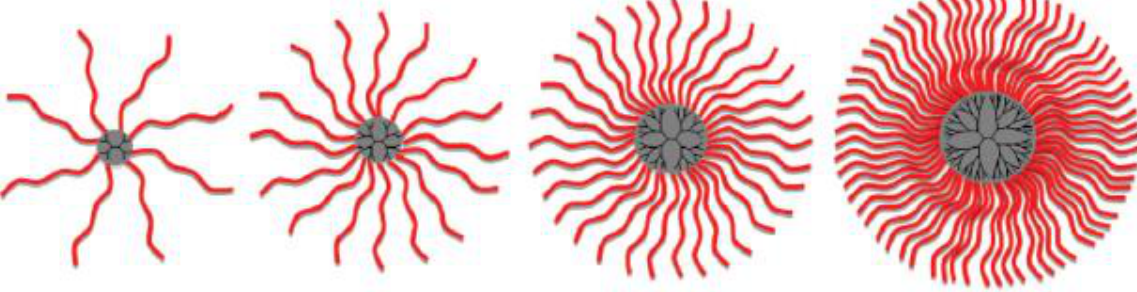
Figure 3. Star-shaped dendrimers synthesized by ring-opening polymerization of ε -carbobenzyloxy- L -lysine N- carboxyanhydride using generation 2nd to 5th generation dendritic macroinitiators. Depending on the generation of macroinitiator, the dendritic structure has a pre-determined number of polymeric “arms” of a rather constant chain length; reproduced with permission from Byrne et al. [29].